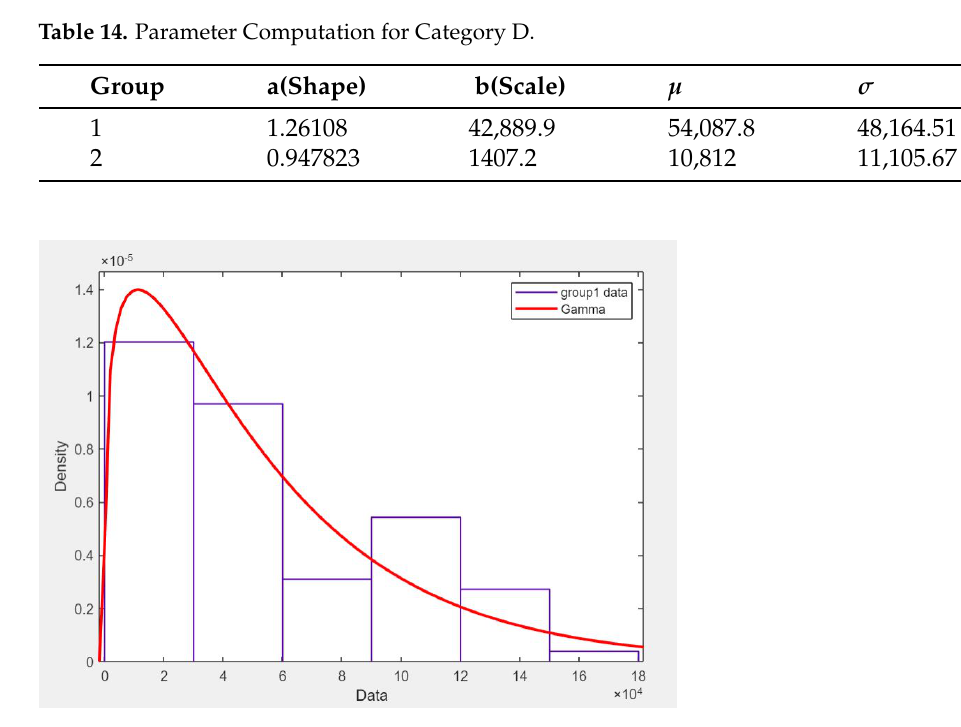
Figure 12. HISTFIT for group 1 in Category